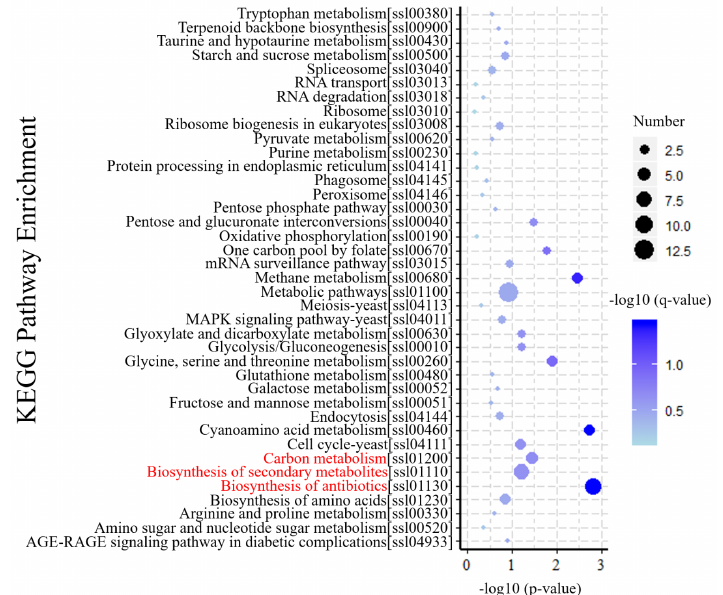
Figure 5. KEGG enrichment analysis of DEGs. The Y-axis of the bubble graph represents the enriched signal pathway. For each item, characters in square brackets are serial numbers related to the KEGG pathway. The X-axis is − log10 ( p -value). The bubble size represents the number of genes, and the color is corrected p-value. The brightness of the blue color corresponds to the magnitude of reliability in the